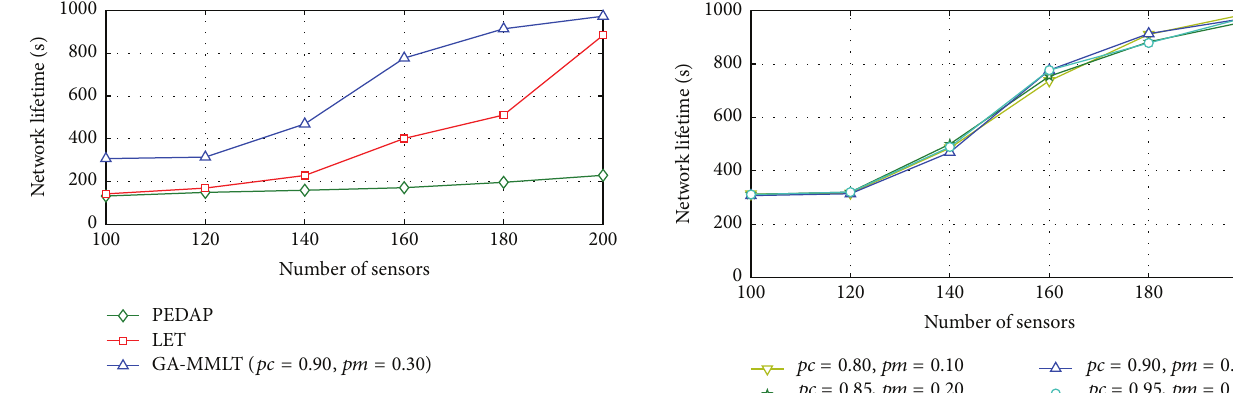
Figure 5: Network lifetime obtained by the three static routing algorithms.